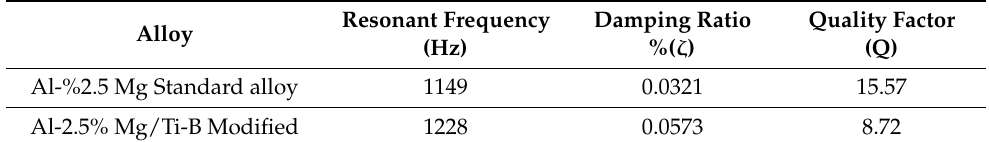
Table 4. Experimental dynamic properties.